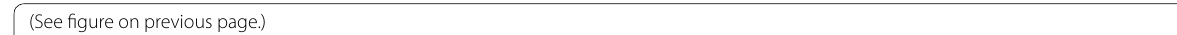
figure on previous Fig. 1 Modular cascade biocatalysis for synthesis of ( R / S )-HMTBA from l -Met. a The modular and combinatorial synthesis of ( R / S )-HMTBA by the proposed modular cascade biocatalysis platform. Three general basic enzyme modules: Basic Module: l -amino acid deaminase ( l -AAD) or l -amino acid oxidase ( l -AAO) for deamination of l -Met to KMTB; Extender Module 1: R-specific dehydrogenase and formate dehydrogenase (FDH) for asymmetric reduction of KMTB to ( R )-HMTBA; Extender Module 2: S-specific dehydrogenase and formate dehydrogenase (FDH) for asymmetric reduction of KMTB to ( S )-HMTBA. b The artificially designed cascade biocatalysis protocol. Cascade 1: modular assembly for ( R )-HMTBA synthesis via cascade BM with EM1. Cascade 2: modular assembly for ( S )-HMTBA synthesis via cascade BM with